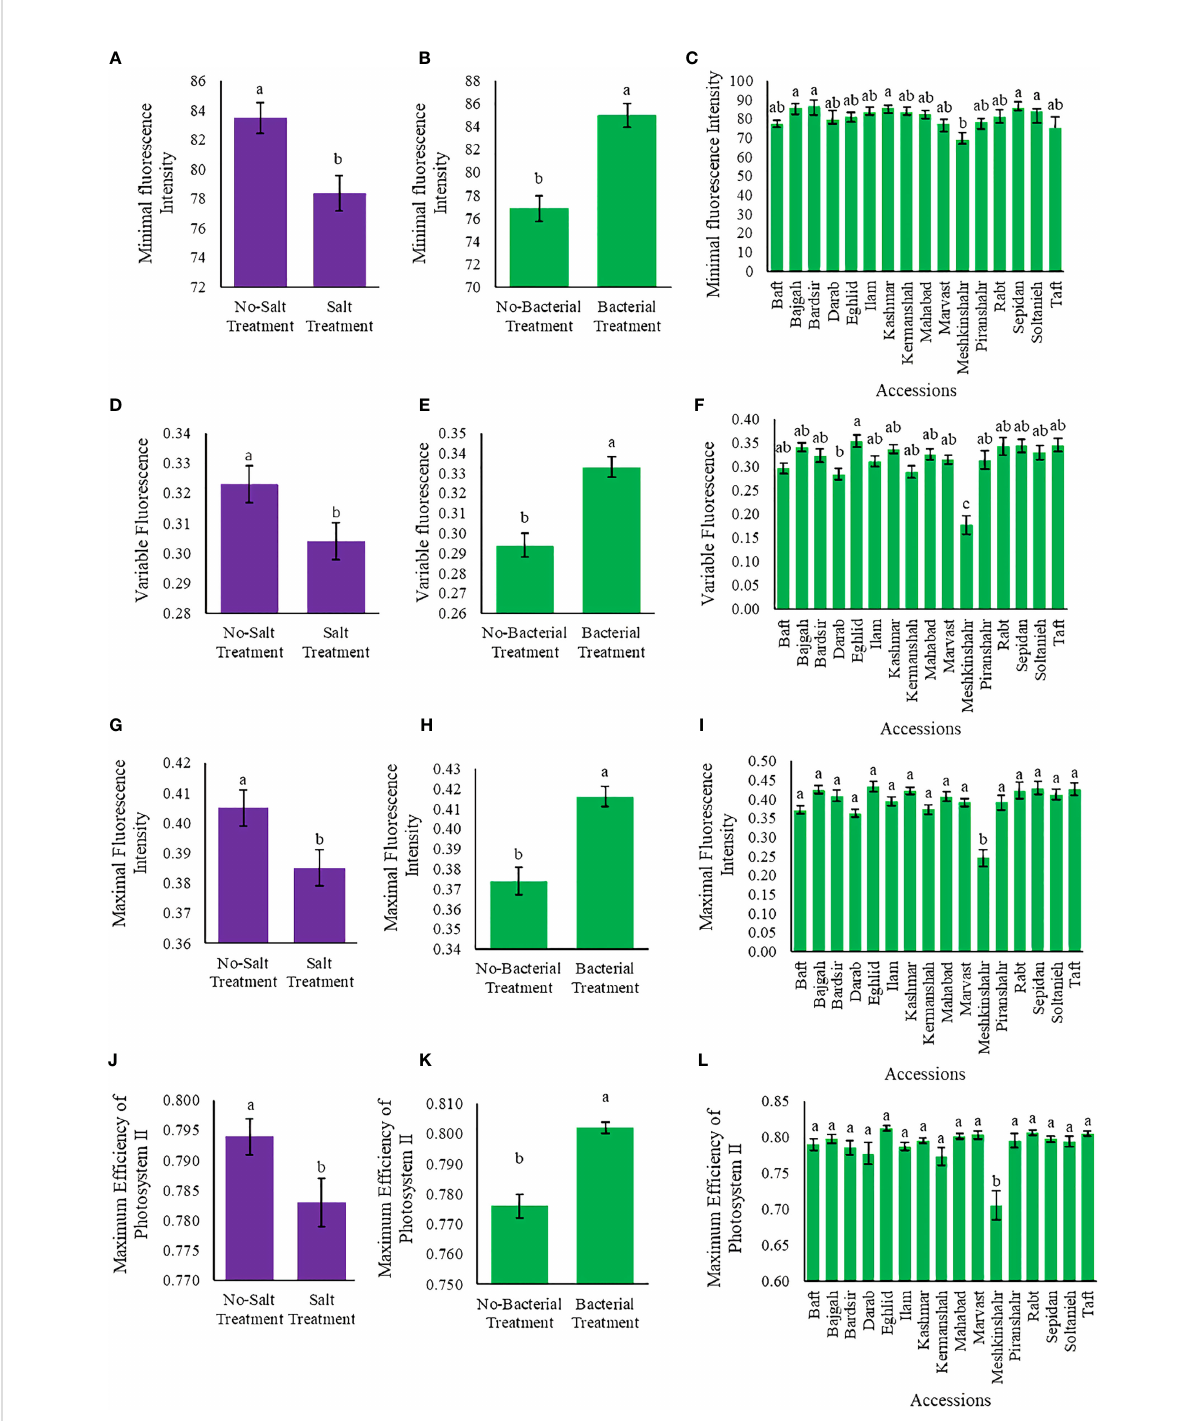
FIGURE 4 Measured parameters variation under studied treatments. Variable fl uorescence (Fv), Maximal fl uorescence intensity (Fm), and Maximum quantum yield (A – C) Minimal fl uorescence intensity (F0), (D – F) Variable fl uorescence (Fv), (G – I) Maximal fl uorescence intensity (Fm) (J – L) Maximum quantum yield (Fv/Fm). According to the analysis of variance, the above present mean comparisons are the only effects that showed signi fi cant difference. Mean values with the same letters are not signi fi cantly different ( p ≤ 0.05), Tukey test. Bars stand for standard error